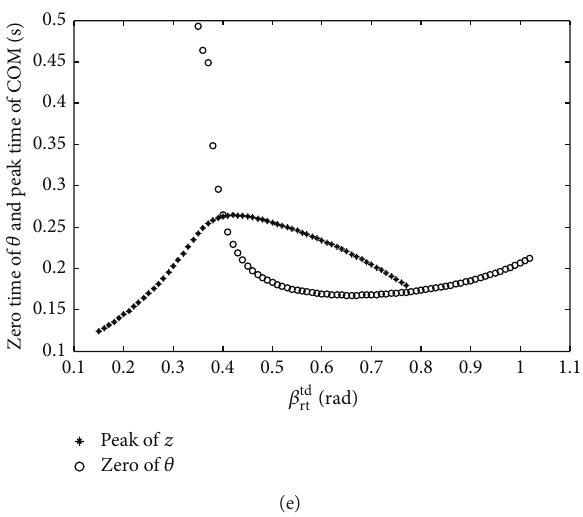
Figure 18: Imbalance and balance postures of basset hound. (a) the imbalance posture when 𝛽 td rt = 0 . 20 rad; (b) the balance posture when 𝛽 td = 0 . 40 rad; (c) the imbalance posture when 𝛽 td rt and the peak time of